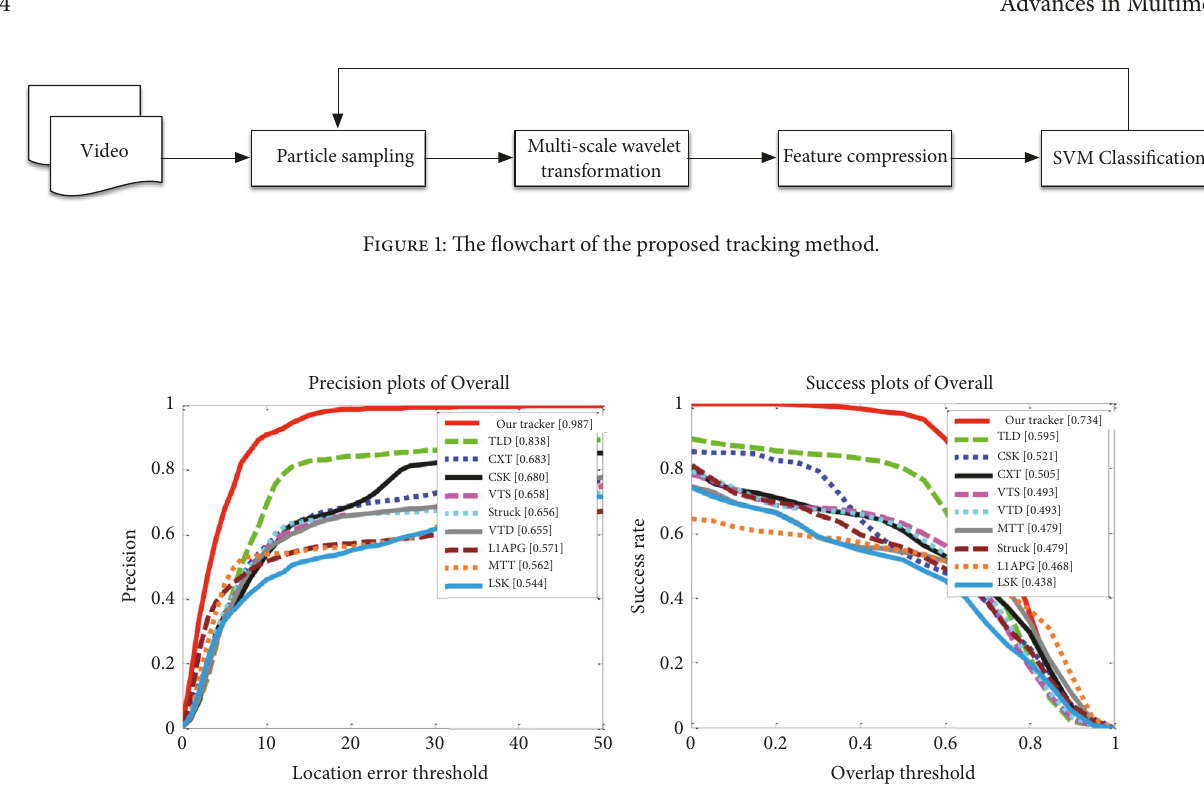
Figure 2: Overall precision plots and success plots on the test